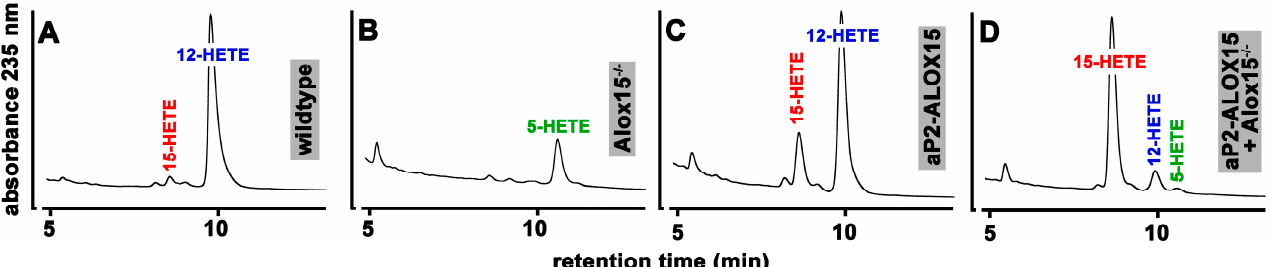
Figure 4. Ex vivo activity assays of peritoneal lavage cells prepared from mice of different genotype. 10 7 peritoneal macrophages prepared from mice of different genotype were incubated with arachidonic acid as described in Section 4, and the oxygenation products were analyzed by RP-HPLC. Representative chromatograms are shown; the statistical evaluation of the data is given in Table 1. Table 1. Ex vivo activity assays of peritoneal lavage cells prepared from mice of different genotype. 10 7 peritoneal lavage cells prepared from mice of different genotypes (n = 3 of each genotype) were incubated with exogenously added arachidonic acid as described in Section 4. The arachidonic-acid- derived oxygenation products were prepared and further analyzed by RP-HPLC. The statistical evaluation of the experimental raw data was performed using the Student’s t-test function of the Microsoft Excel software package. # wildtype mice vs. aP2-ALOX15 animals, p < 0.01, § aP2-ALOX15 mice vs. aP2-ALOX15 + ALOX15 − / − animals p < 0.01. Genotype